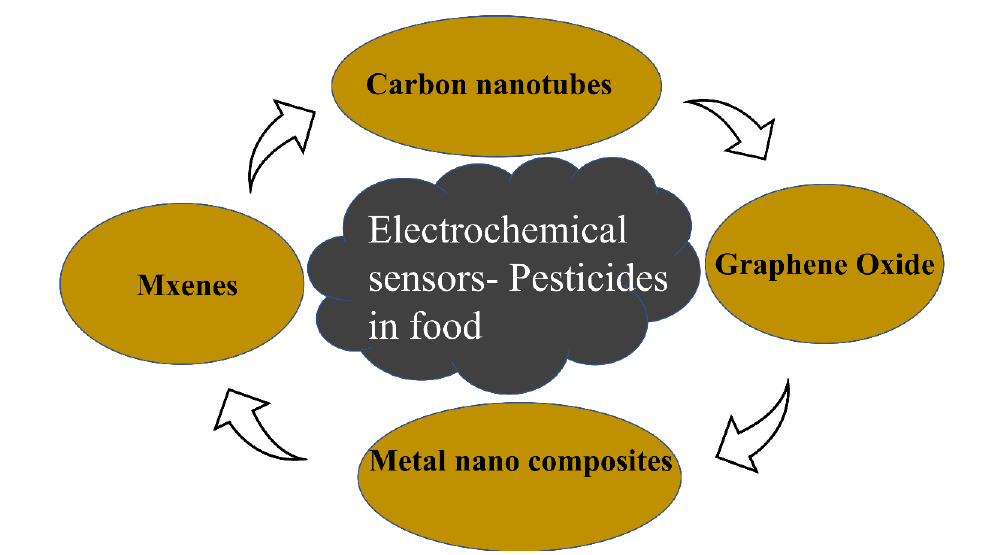
Figure1. Nanomaterials employed for the electrochemical detection of pesticides in